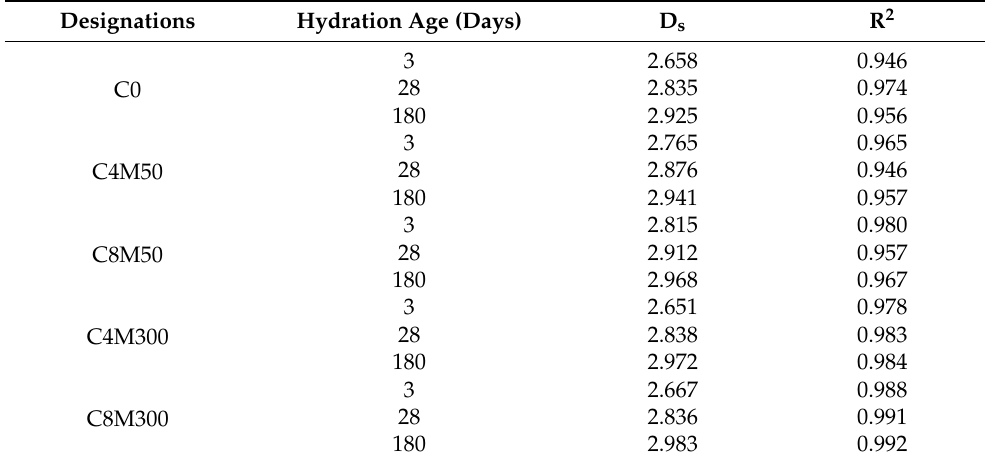
Table 6. Fractal dimension of pore surface (D s ) of concretes added with MgO.